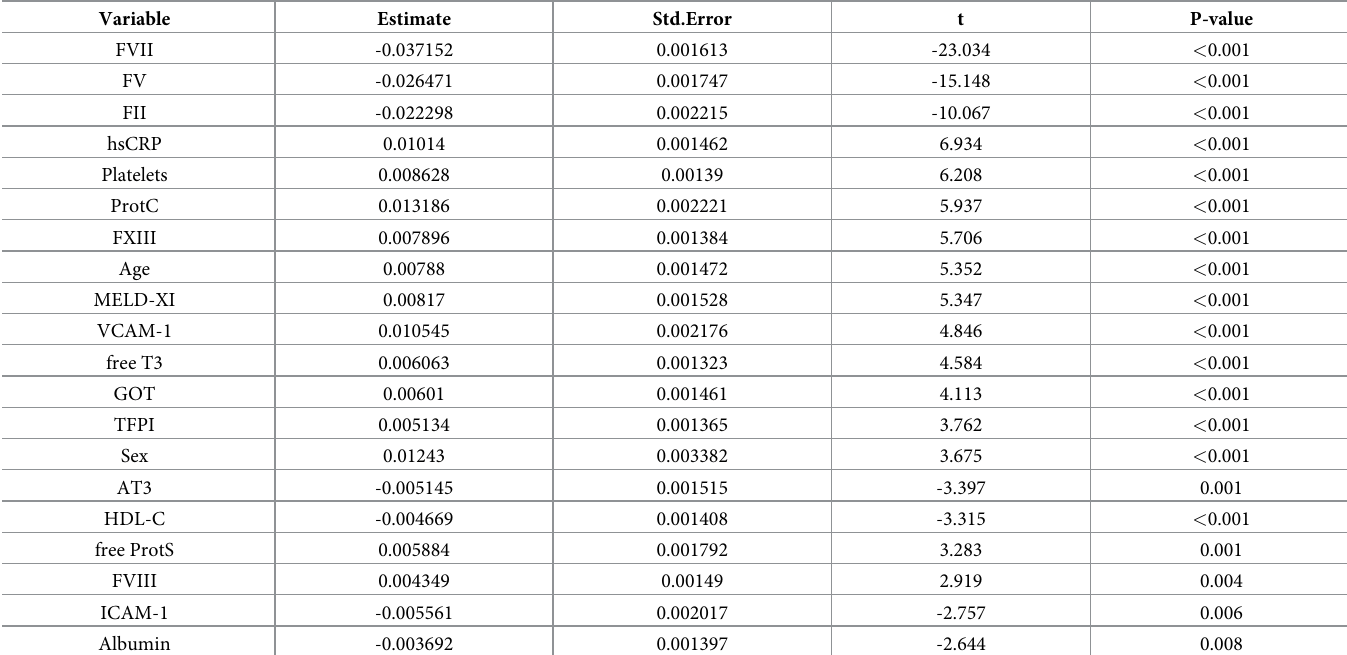
Table 2. Estimates of a linear regression model of